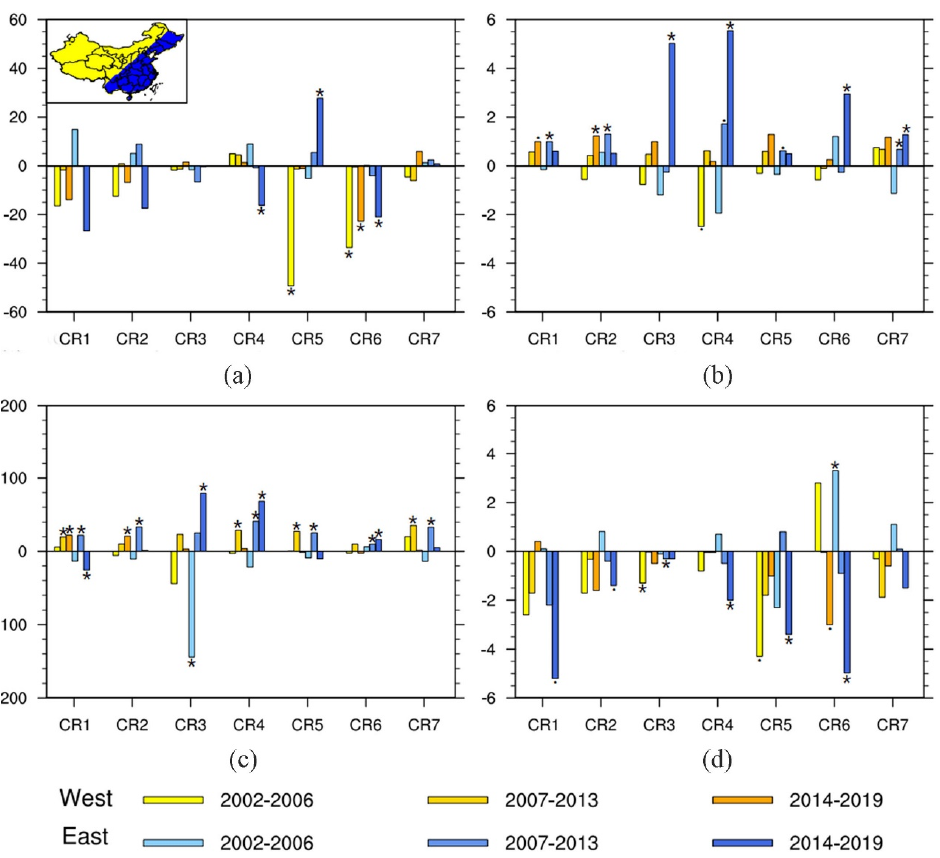
Figure 4. The trend of cloud properties for each regime in western and eastern China. ( a ) CTP, unit: hPa/18 years, ( b ) COT, unit:/18 years, ( c ) LWP, unit: g/(m 2 ∙18 years), and ( d ) TCC, unit: %/18 years. Asterisks indicate that the linear regression coefficient has passed the significance level of 0.05 and dots indicate that the linear regression coefficient has passed the significance level of 0.10. The insert map colors the eastern China in blue and western China in yellow with “Heihe−Tengchong Line” as the divide.